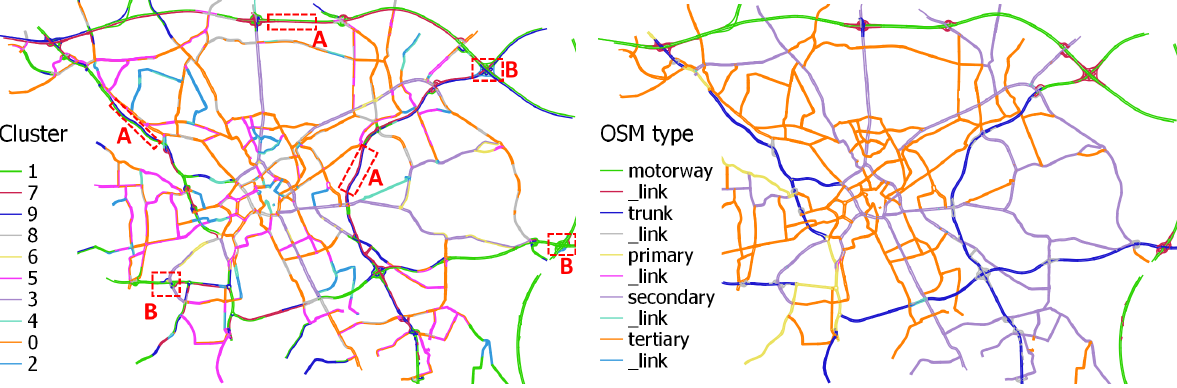
Figure 7. The resulting clusters of similar street segments (left) and OSM road types (right) for visual comparison. Comparing our solution to the original OSM road types (see Fig- ure 7, right) a general correspondence between both can be recog- nized, after a rough resorting of the color assignment. The calcu- lated overlap between both is about 42%. The top three clusters 1, 7 and 9 (light-green, red, dark-blue) are basically motorways, trunks and partly complemented by primary streets. Secondary roads are especially inner city main axes, which are covered by cluster 3 (pale-purple). Tertiary streets seem to be split into clus- ters 0 and 2 (orange and light-blue).